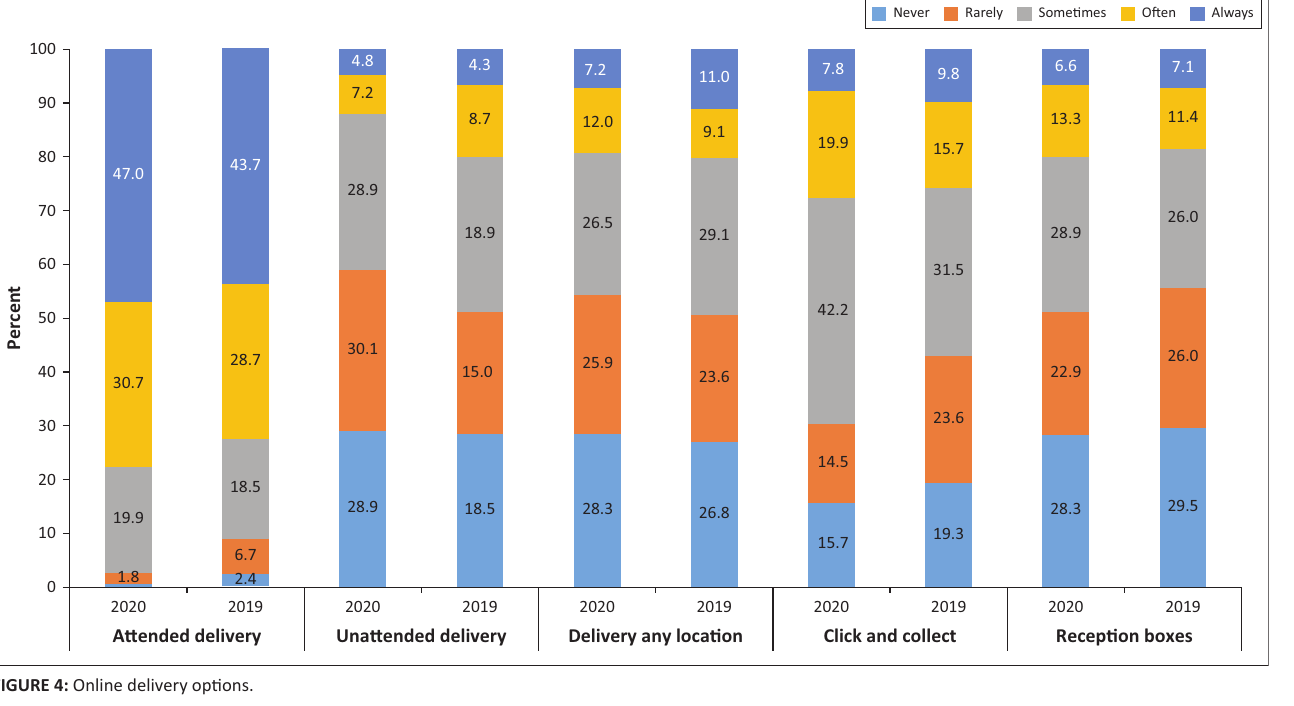
Very unimportant Somewhat unimportant Neither important or